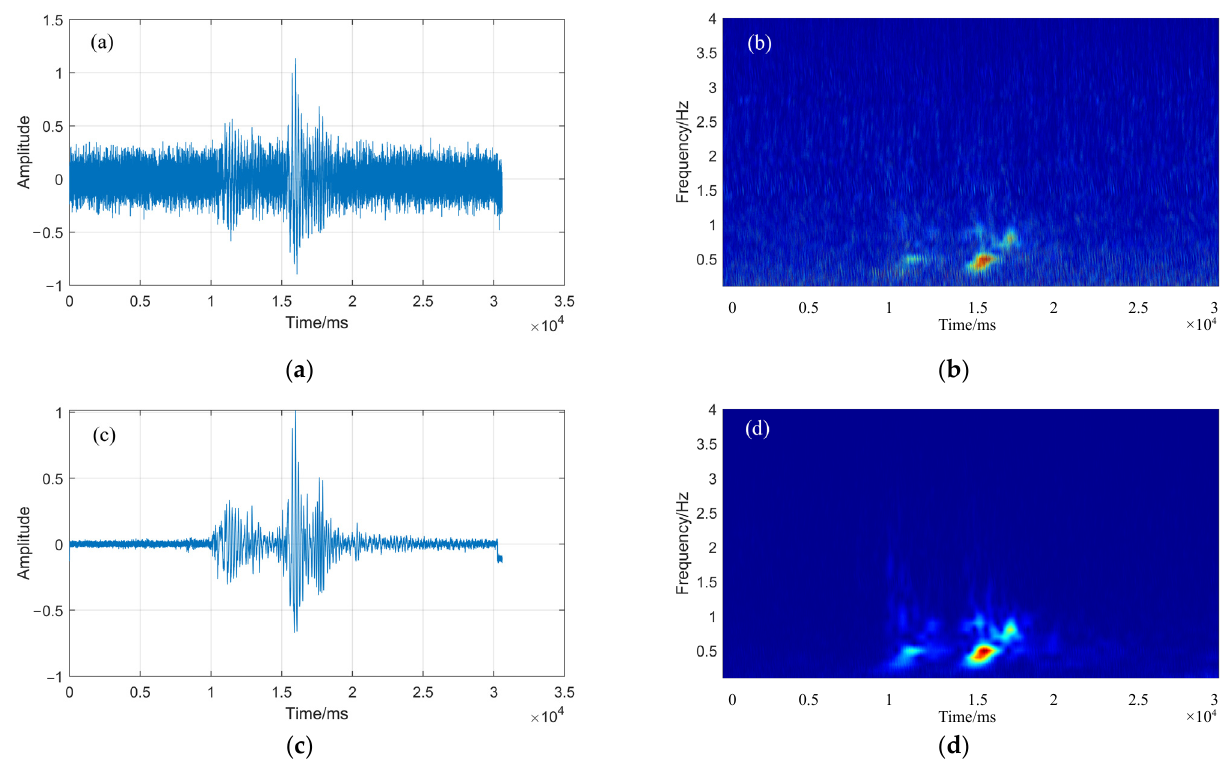
Figure 2. Seismic signals and time-frequency diagrams under different SNR (0 dB and 20 dB). ( a , b ) are the seismic waveform and time-frequency diagram of SNR = 0 dB; ( c , d ) are the seismic waveform and time-frequency diagram of SNR = 20 dB.